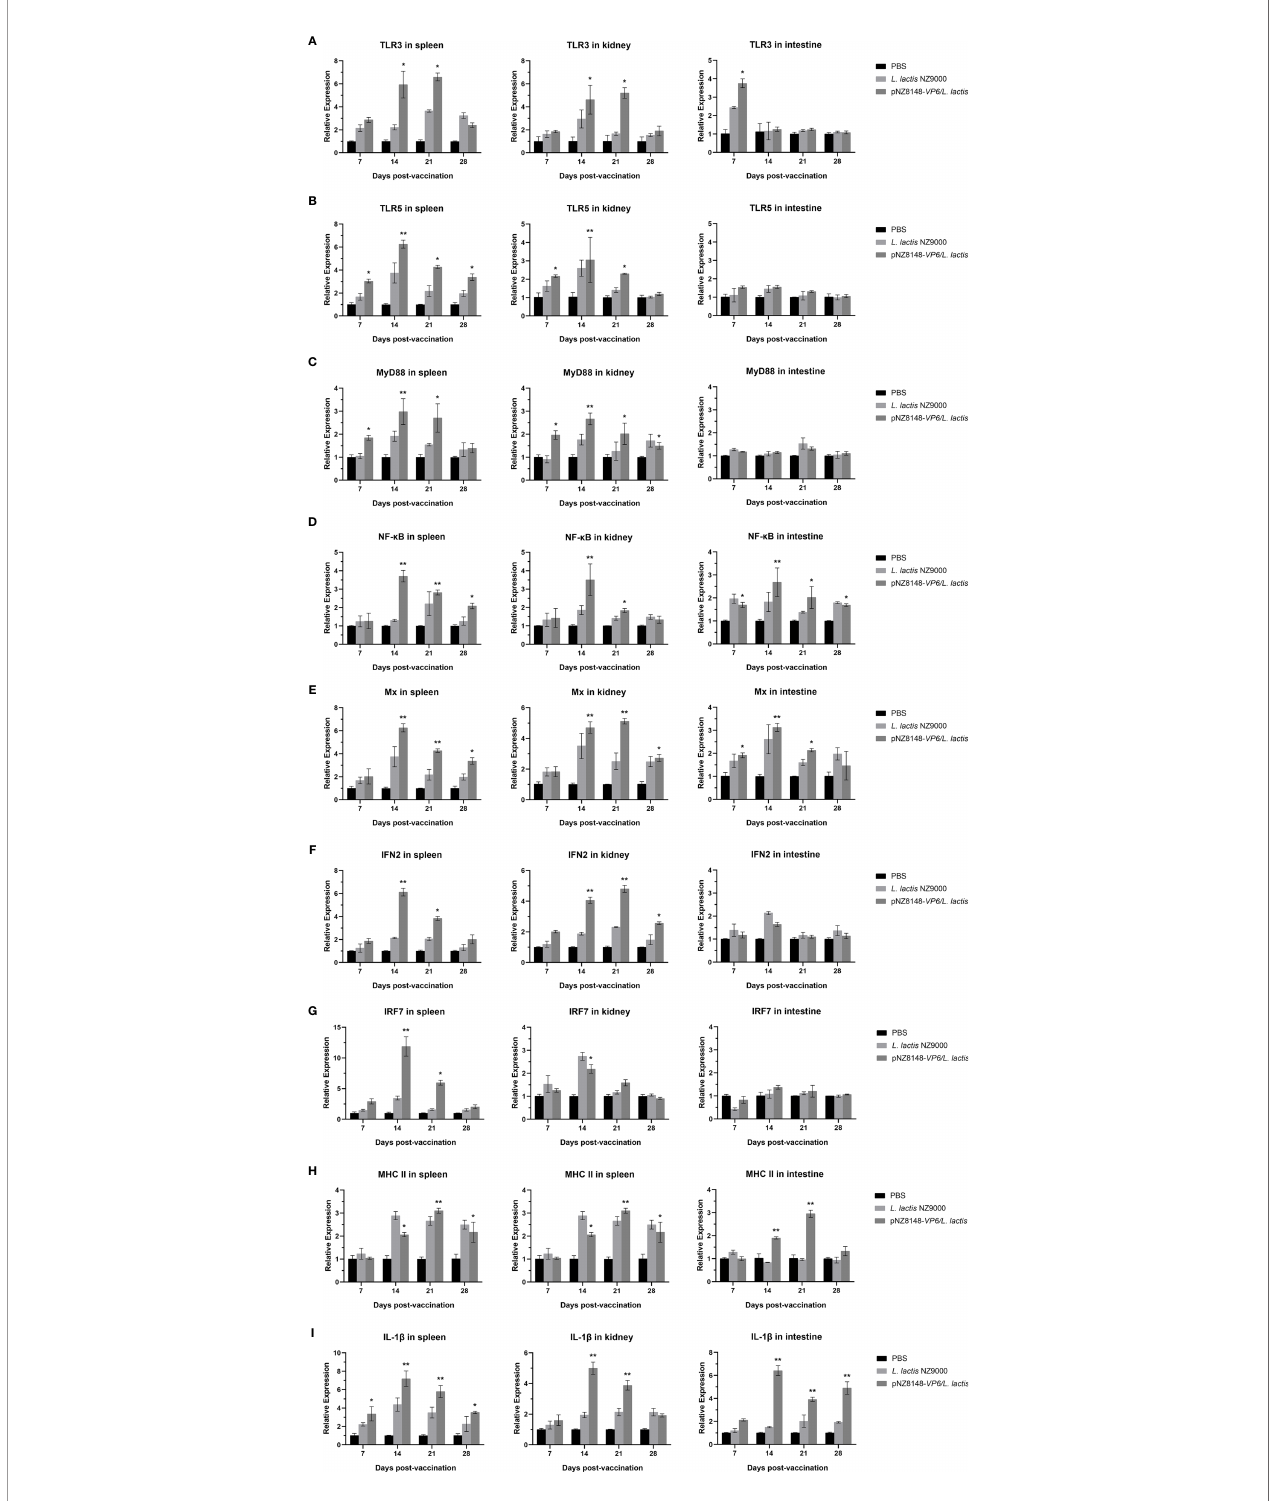
FIGURE 6 | RT-qPCR analysis of the expression of immune-related genes in different tissues of the rare minnow. (A) TLR3, (B) TLR5, (C) MyD88, (D) NF- k B, (E) Mx, (F) IFN2, (G) IRF7, (H) MHC II, (I) IL-1 b . The mRNA level of each gene was normalized on the basis of b -actin gene expression. *p < 0.05, **p < 0.01 (versus PBS